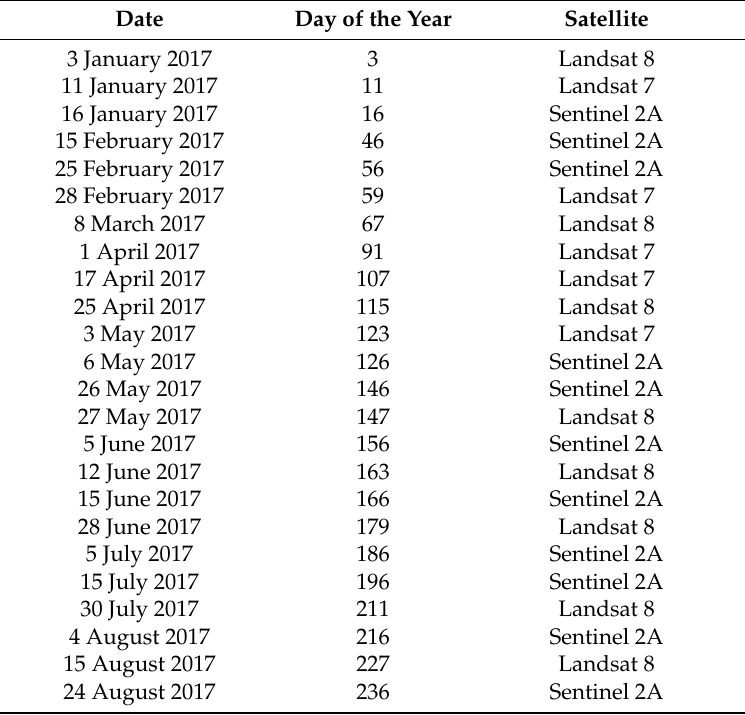
Table 2. Satellite imagery used for model validation during the peach growing season.